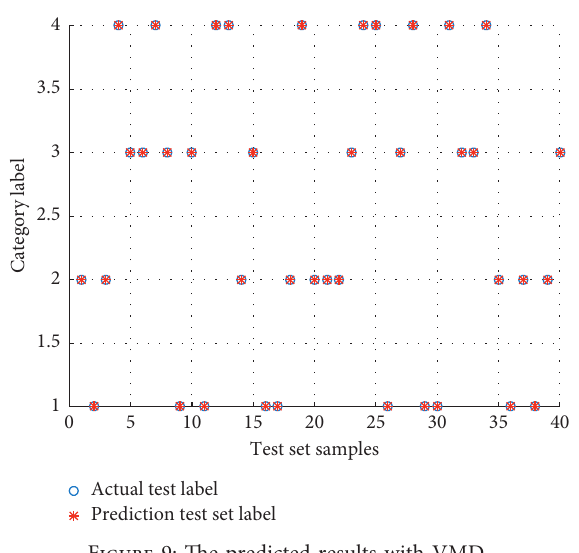
Figure 9: The predicted results with VMD.